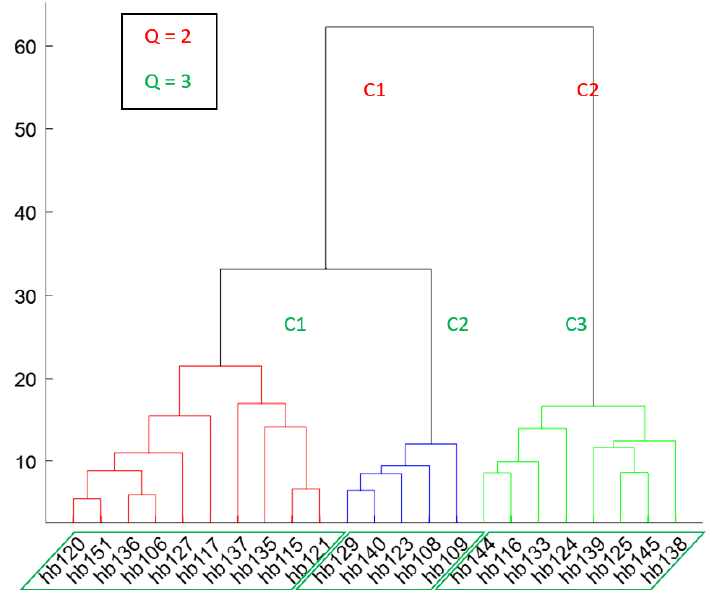
Figure 13. Dendrogram of the agglomerative hierarchical clustering for the urban environment on the weekday. Clustering solutions for Q = 2 (in red) and Q = 3 (in green) are also